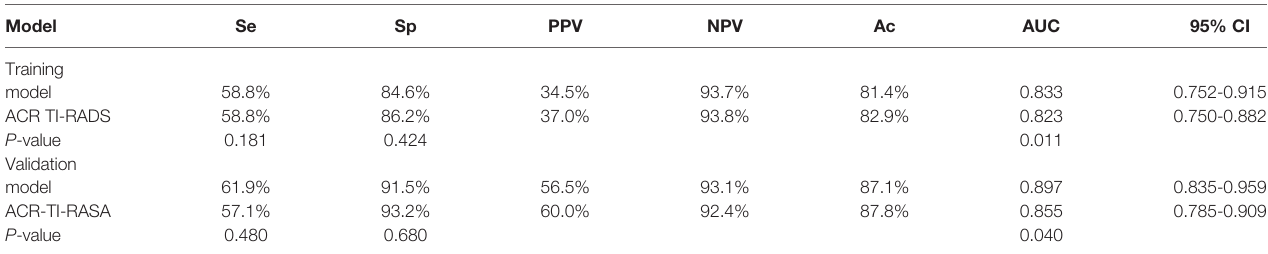
TABLE 6 | Diagnostic performance between the proposed model and ACR